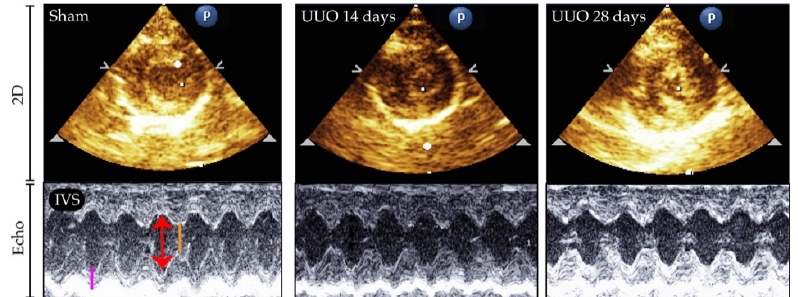
Figure 2. Representative two-dimension (2D) image and echocardiographic (Echo) analysis in the left ventricle (LV) of animals with unilateral ureteral obstruction (UUO) for 14 and 28 days. IVS: interventricular septum; LVEDd: LV dimension at end-diastole (red arrow); LVEDs: LV dimension at end-systole (orange line); LVPW: LV dimension at the posterior wall (pink line). Table 1. Cardiac structural and functional parameters in rats subjected to unilateral ureteral ob- Structural parameters such as the interventricular septum (IVS), left ventricular dimen- struction (UUO) for 14 and 28 days. Data are the mean ± SEM of 9–10 different animals in each sion at end-systole (LVEDs), and left ventricular at end-diastole (LVEDd) were unchanged experimental group. IVS: interventricular septum; LVEDd: LV dimension at end-diastole; LVEDs: LV dimension at end-systole; LVPW: LV dimension posterior wall, EF: ejection fraction; FS: frac- tional shortening; HR: heart rate; bpm: beats per minute. UUO (Days)